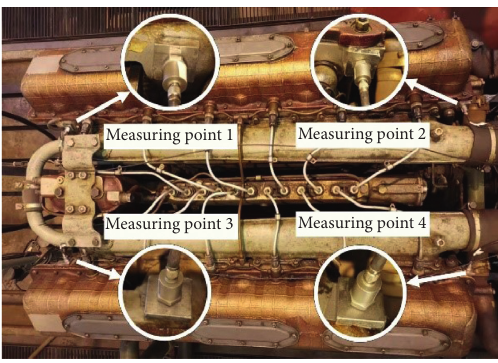
Figure 8: The measuring points. Table 2: Description of the cylinder